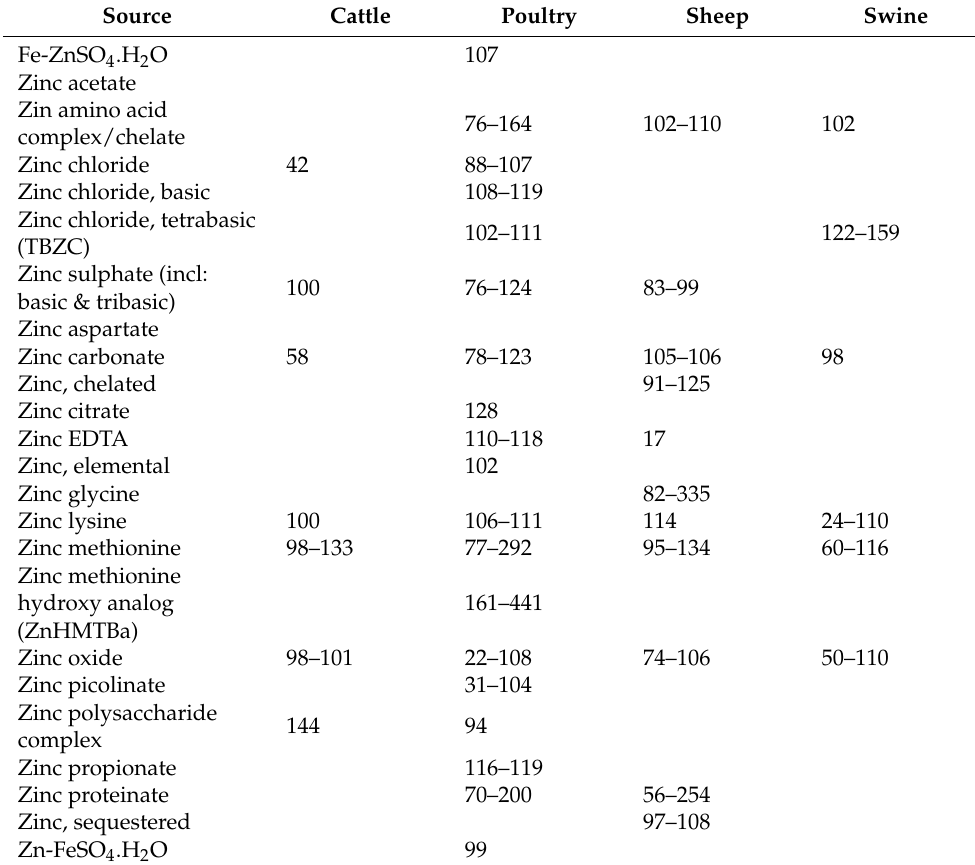
Table 7. Multi-species table of relative bioavailability values (%) for zinc 1,2